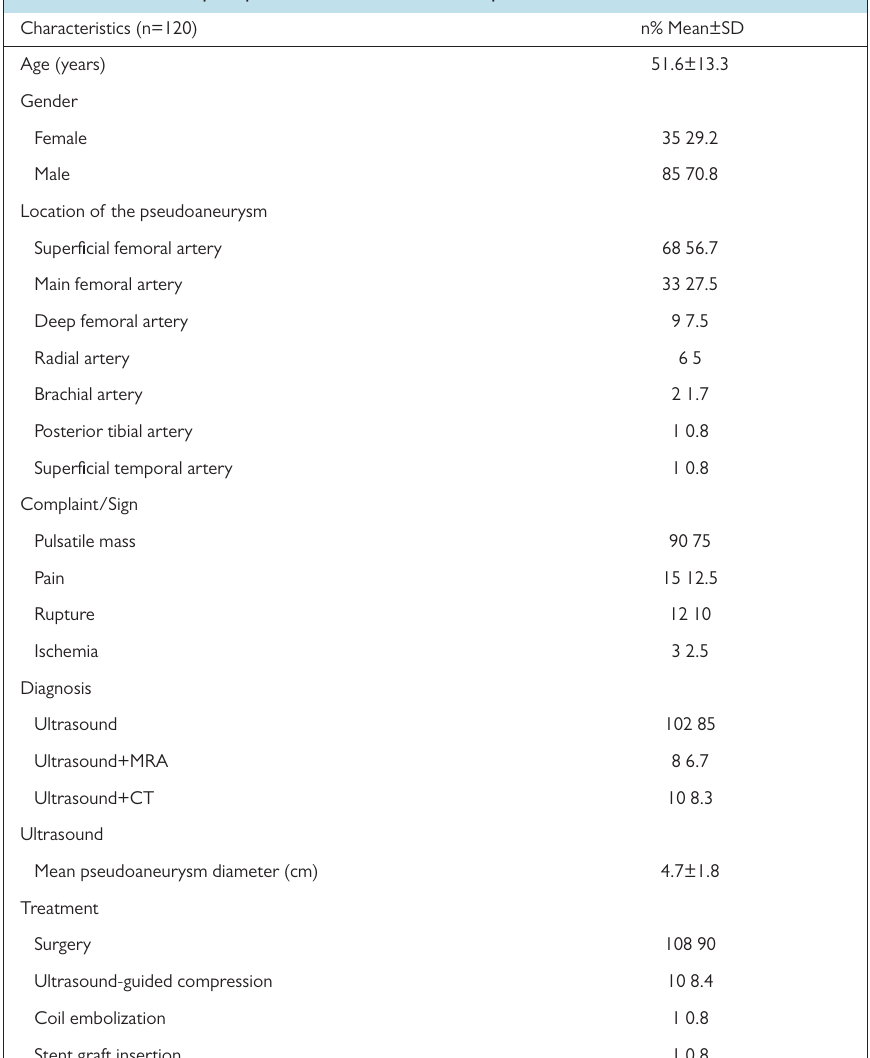
Table 1. General and perioperative characteristics of the